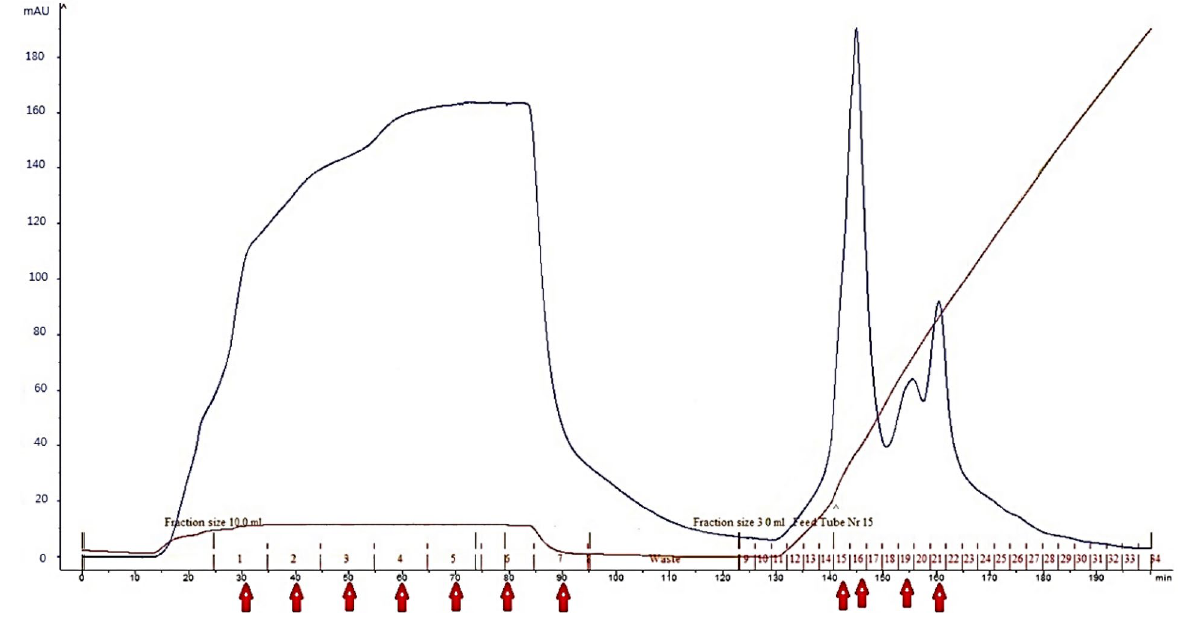
Figure 1. Ion exchange chromatogram obtained from the fraction < 3 kDa using a Q column.